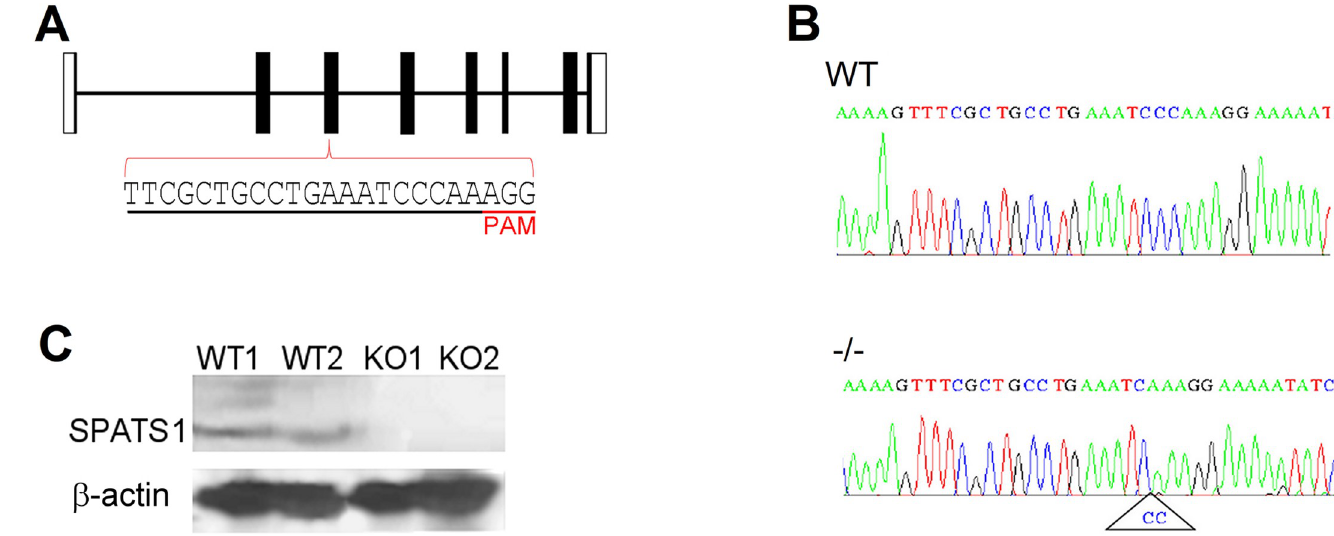
Fig 2. Genomic structure and knockout strategy of Spats1 . (A) Graphical representation of the structure of mouse Spats1 . Coding exons appear as solid black bars and non-coding exons as white bars. Introns are represented as horizontal lines. Sequence of the sgRNA, designed to target exon 3, is underlined in black, and the PAM sequence is underlined in red. (B) Representative genotyping results obtained through sequencing of PCR products amplified from mouse tail tips. The 2 bp deletion in Spats1 -/- mutants is shown. (C) Western blot analysis showing the detection of SPATS1 in testicular lysates of two WT mice, but not in those of 2 KO ones. β -actin was used as a loading control.